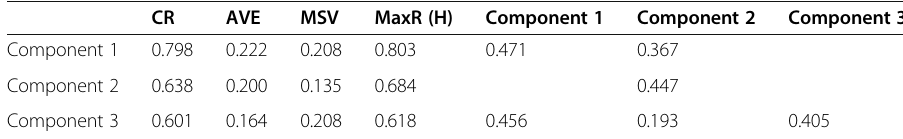
Table 8 The CR, AVE, and MSV